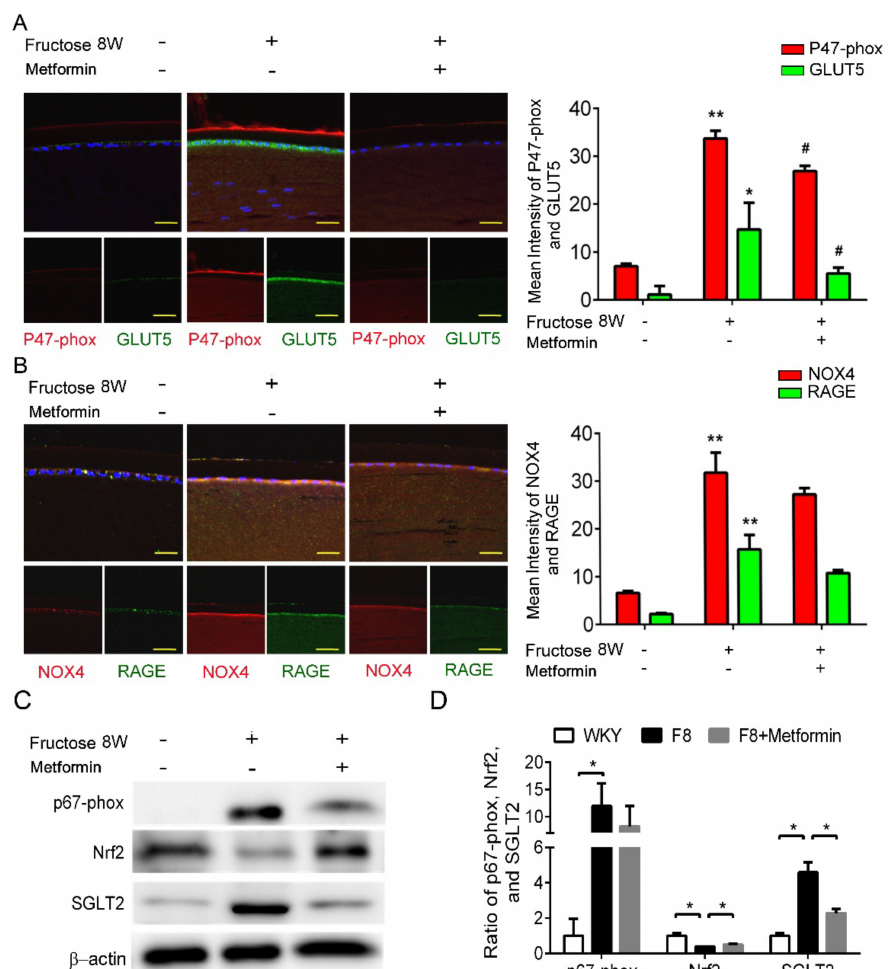
Figure 3. Metformin effectively reverses SGLT2-induced GLUT5 and NADPH oxidase subunit (p47 − phox) in the fructose − induced type 2 DM lens. ( A , B ) Representative images showing GLUT5- positive (green) and p47 − phox-positive (red) cells in the lens with or without metformin, compared to no fructose group. Cell nuclei are counterstained with DAPI (blue). ( C , D ) Quantitative analyses for p67 − phox and SGLT2 after metformin was provided to the animals. Values are presented as mean ± SEM ( n = 6 per group). Scale bar = 20 µ m. * p < 0.05 and ** p < 0.001; # p < 0.05 versus Fructose 8